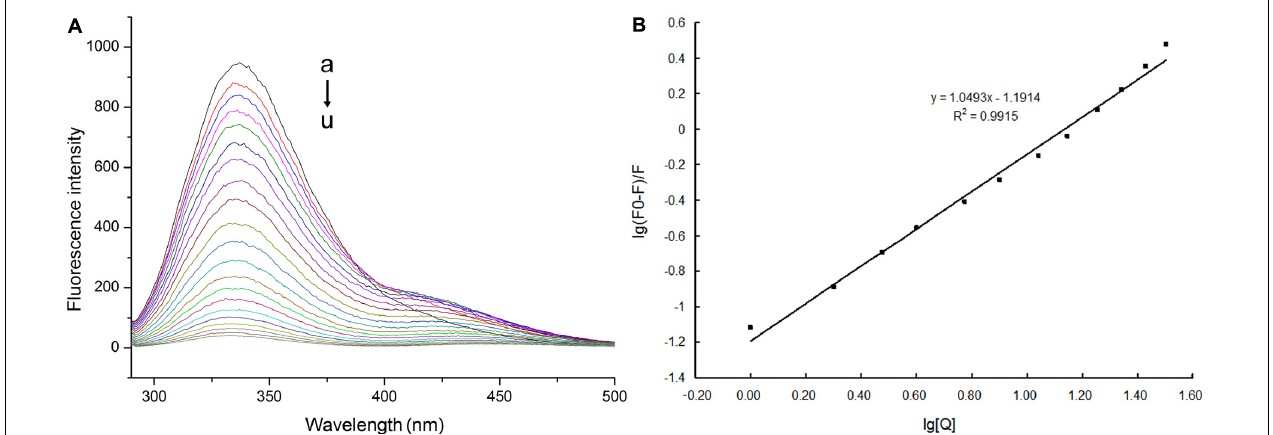
FIGURE 8 | Fluorescence spectra and plots of log[( F 0 − F )/ F ] versus log[ Q ] for NlCDK1 binding with schaftoside. (A) C (schaftoside)/( µ mol L − 1 ): a, 0; b, 0.5; c, 1.0; d, 2.0;e, 3.0; f, 5.0; g, 7.0; h, 10.0; i, 13.0; j, 17.0; k, 21.0; l, 28.0; m, 35.0; n, 45.0; o, 55.0;p, 67.0; q, 79.0; r, 93.0; s, 107.0; t, 123.0; u,